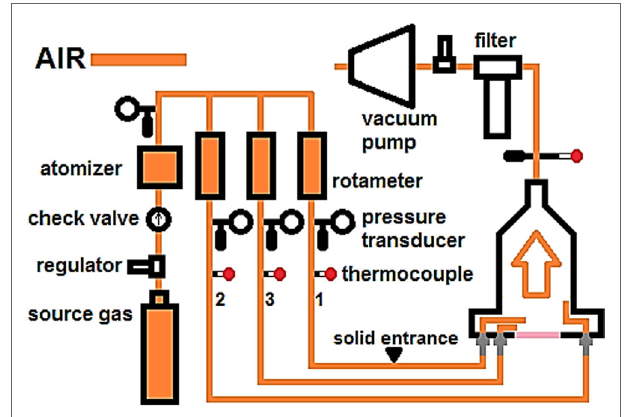
FigUre 2 | schematic of the flow control system